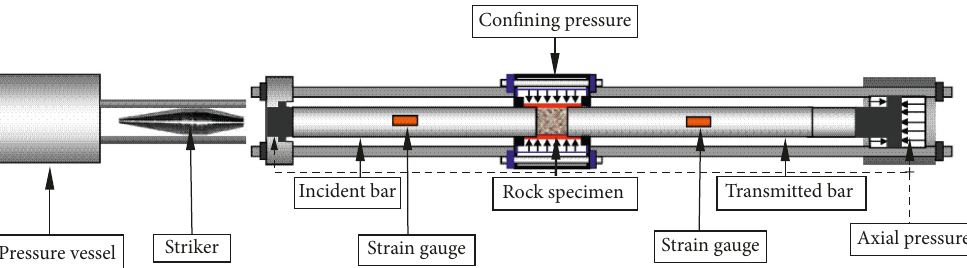
Figure 3: A flow diagram of SHPB (the experimental system).